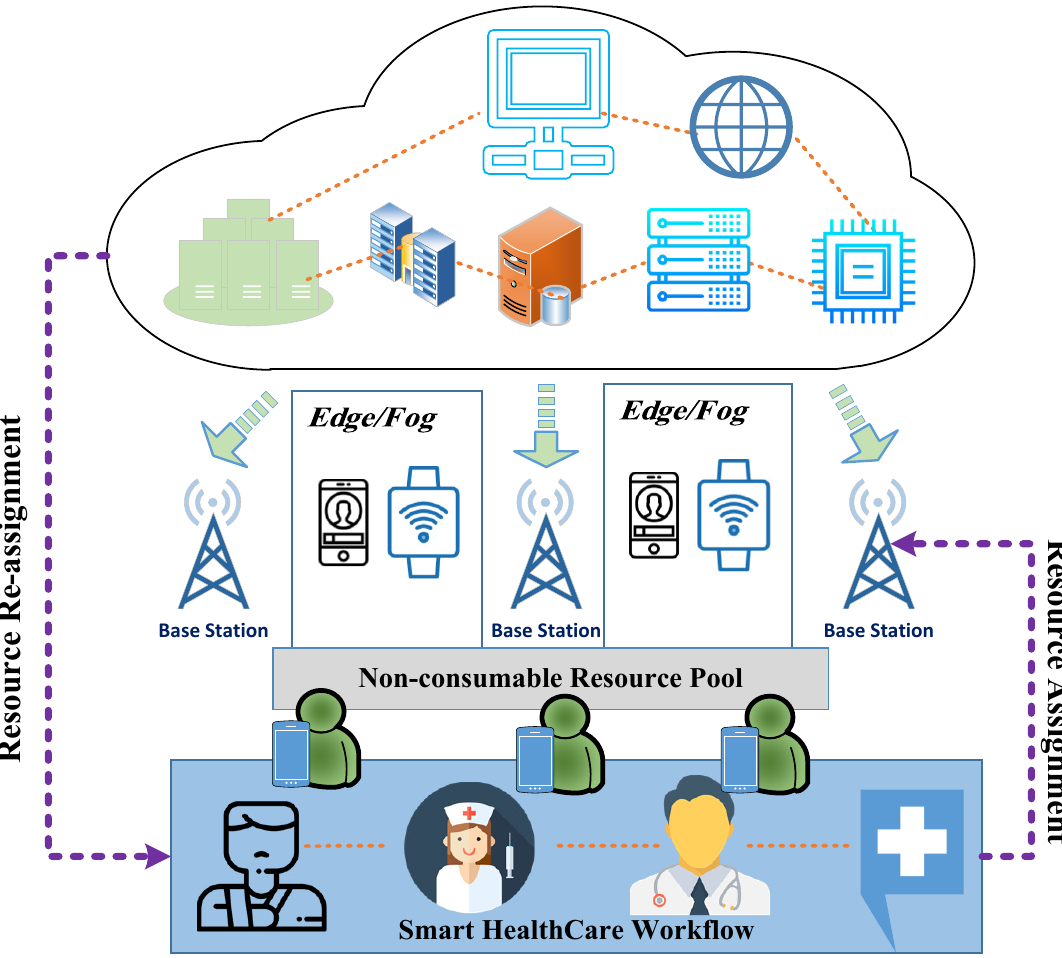
Figure 1. An edge based smart healthcare